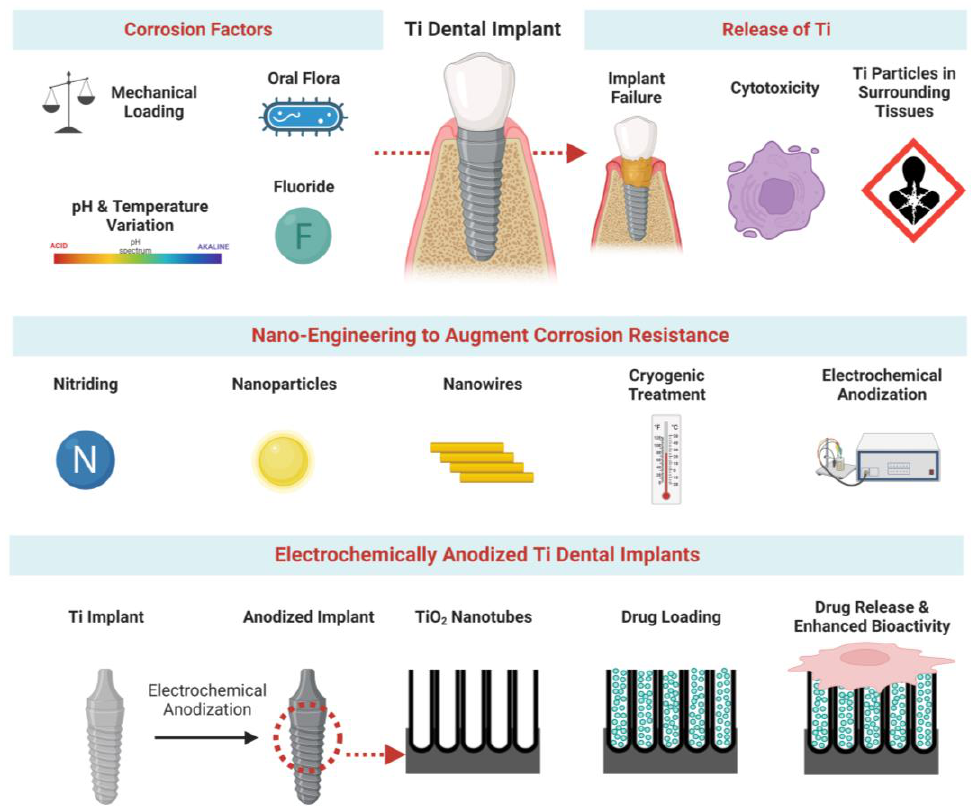
Figure 1. Corrosion and local drug delivery from Ti dental implants. Schematic representation showing corrosion factors, nano-engineering to augment corrosion resistance, and anodized Ti den- tal implants towards drug release and enhanced